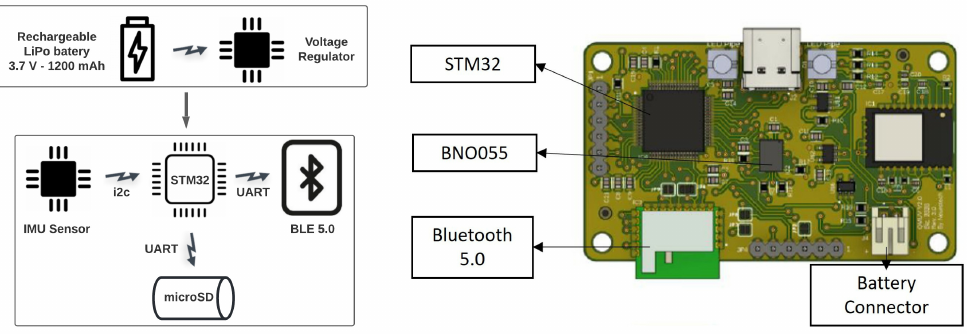
Figure 2. General electronic scheme and electronic PCB design of the implemented motion